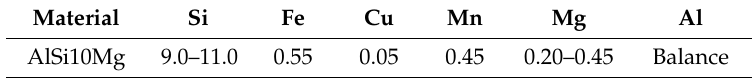
Table 1. Chemical composition of the additive manufacturing (AM) powder by weight %. Material